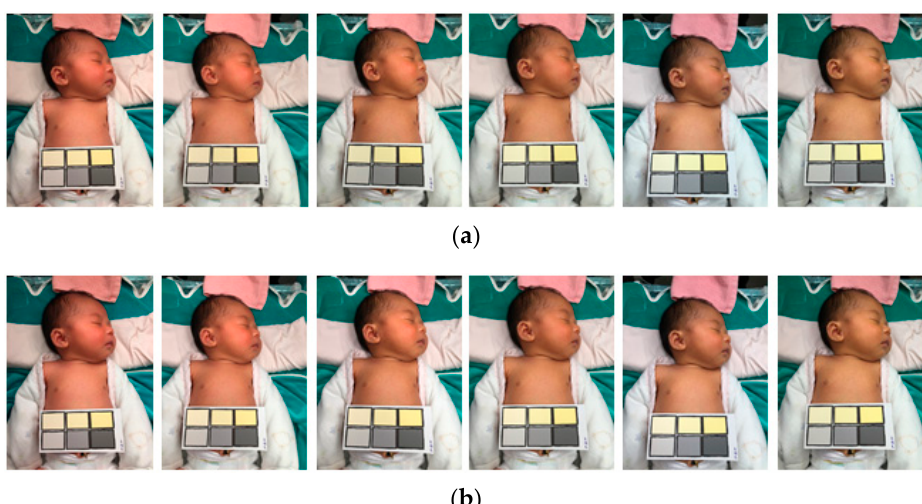
Figure 6. High risk of bilirubin level in control group. ( a ) Original images; ( b ) adjusted images with the proposed method.